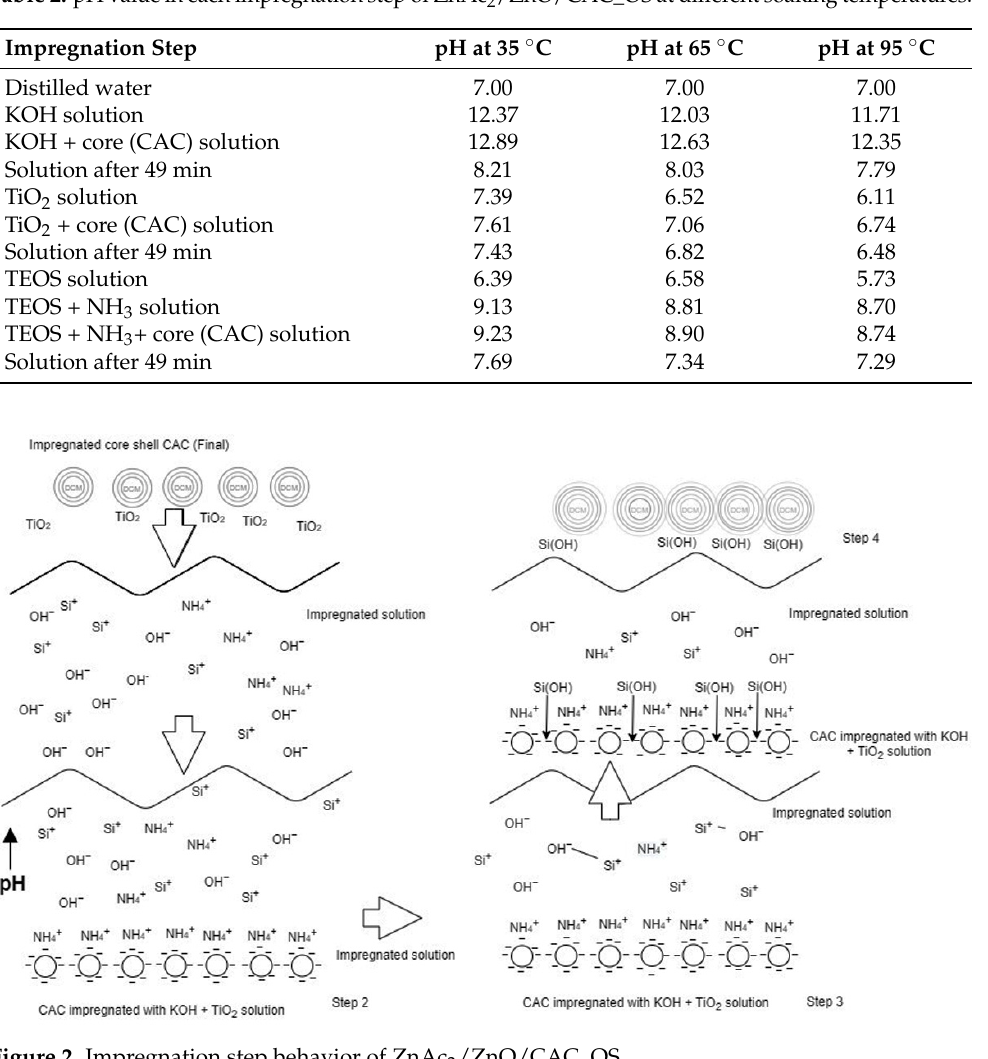
Figure 2. Impregnation step behavior of ZnAc 2